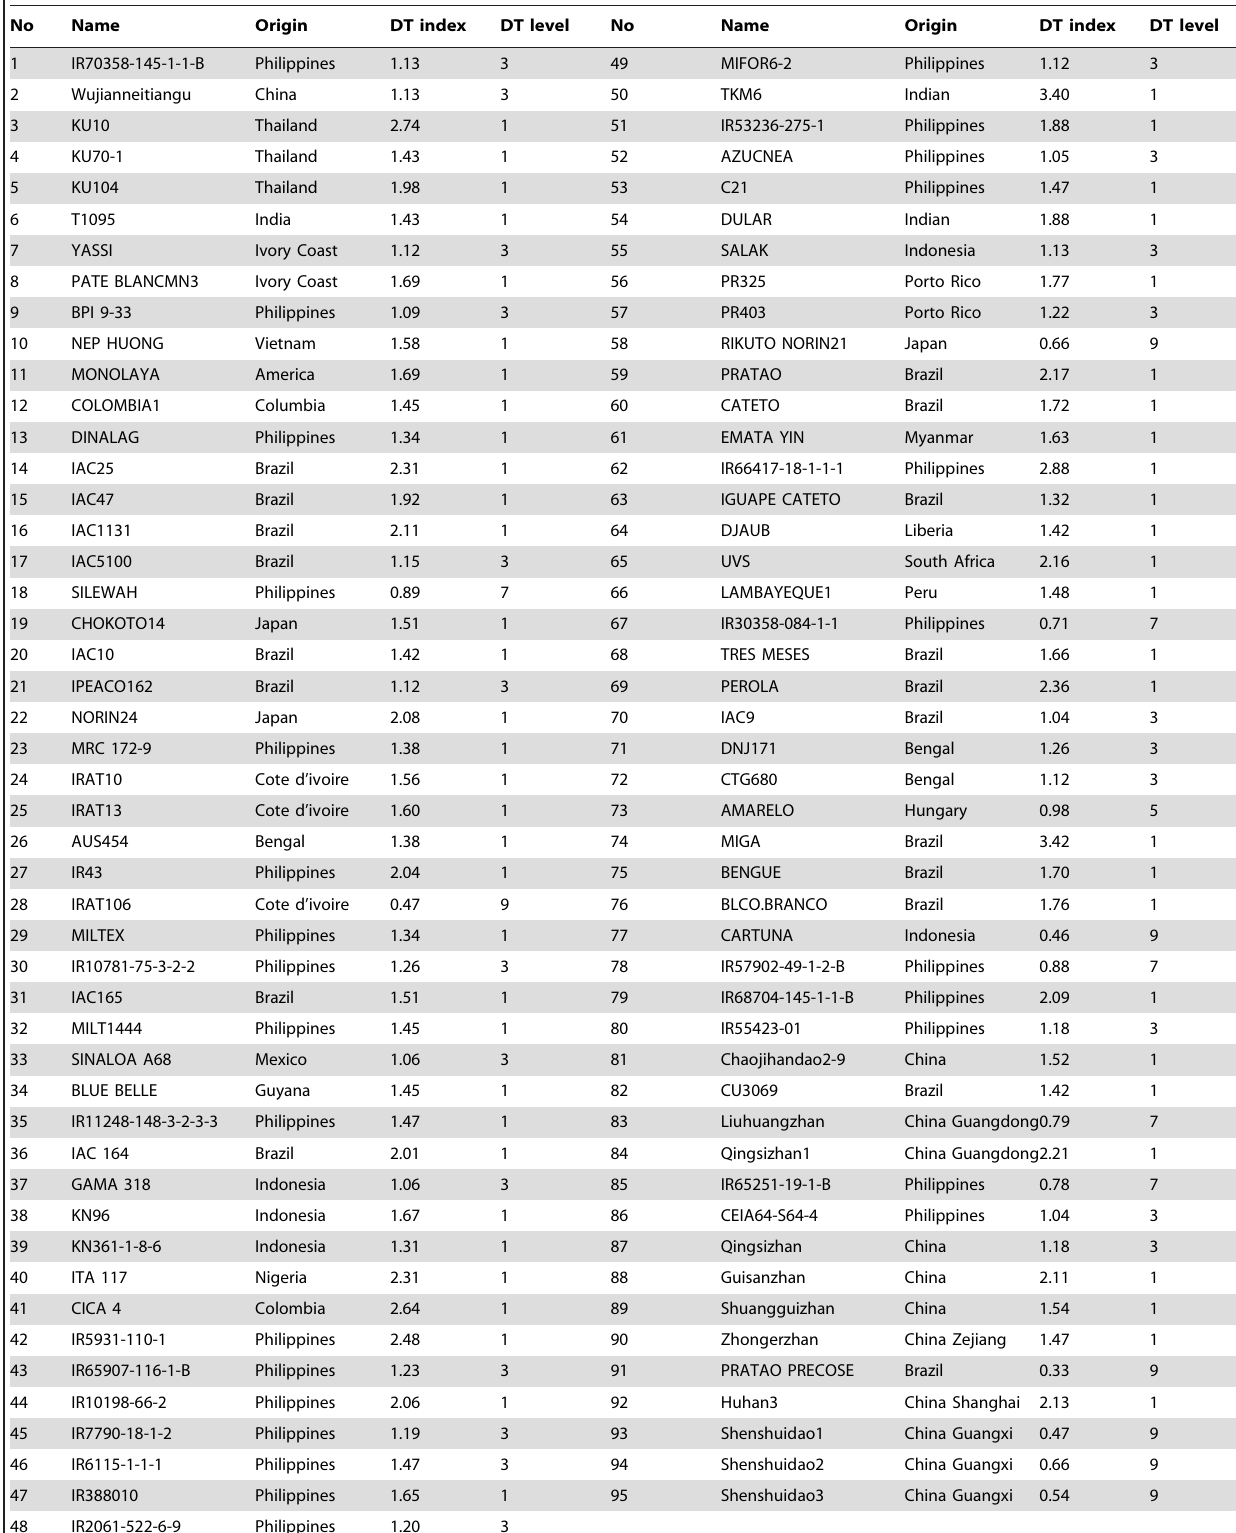
Table 1. Basic information on the tested cultivated